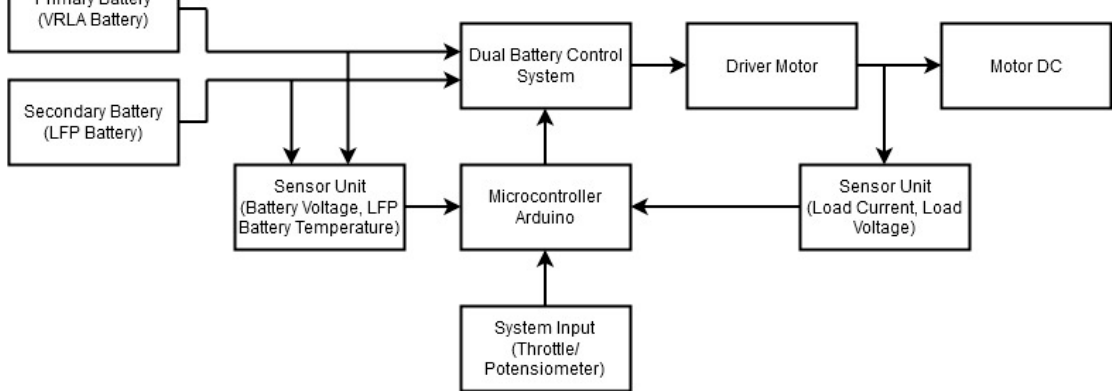
Figure 7. Block diagram of a simple electric vehicle with dual battery system.